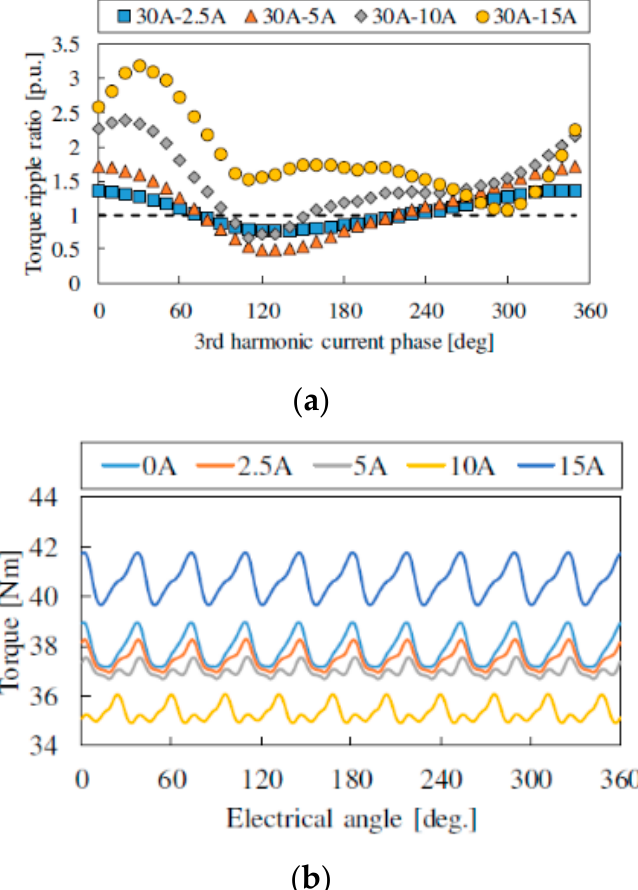
Figure 13. ( a ) Torque ripple ratio characteristics with 3rd harmonics current. Fundamental current is 30 A, 2.5 A–15 A harmonics are added. ( b ) Output torque waveforms when 3rd harmonics is added to the fundamental current.